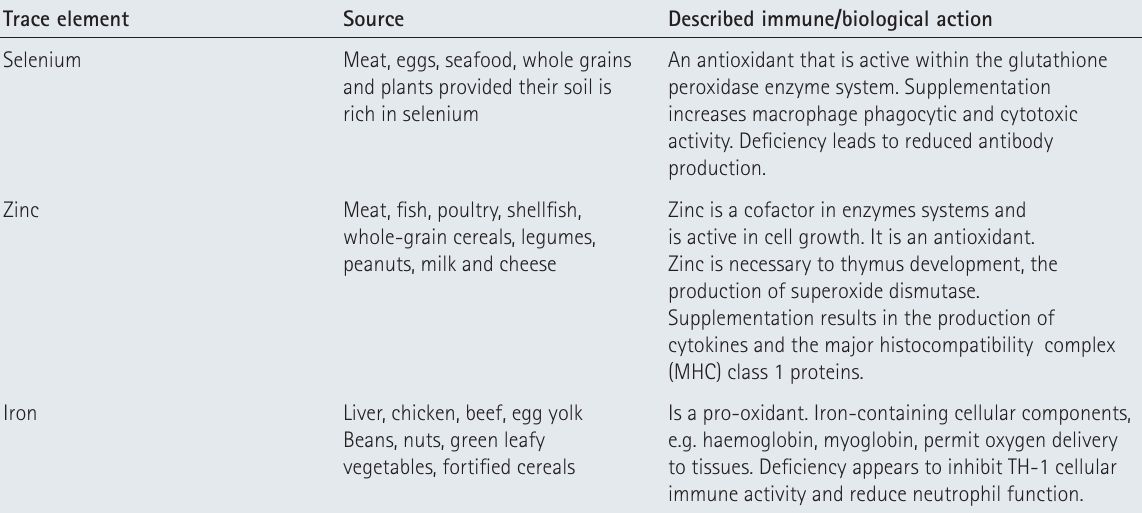
TABle 3.III. TRACe eleMeNTs AND IMMUNe/BIOlOGICAl